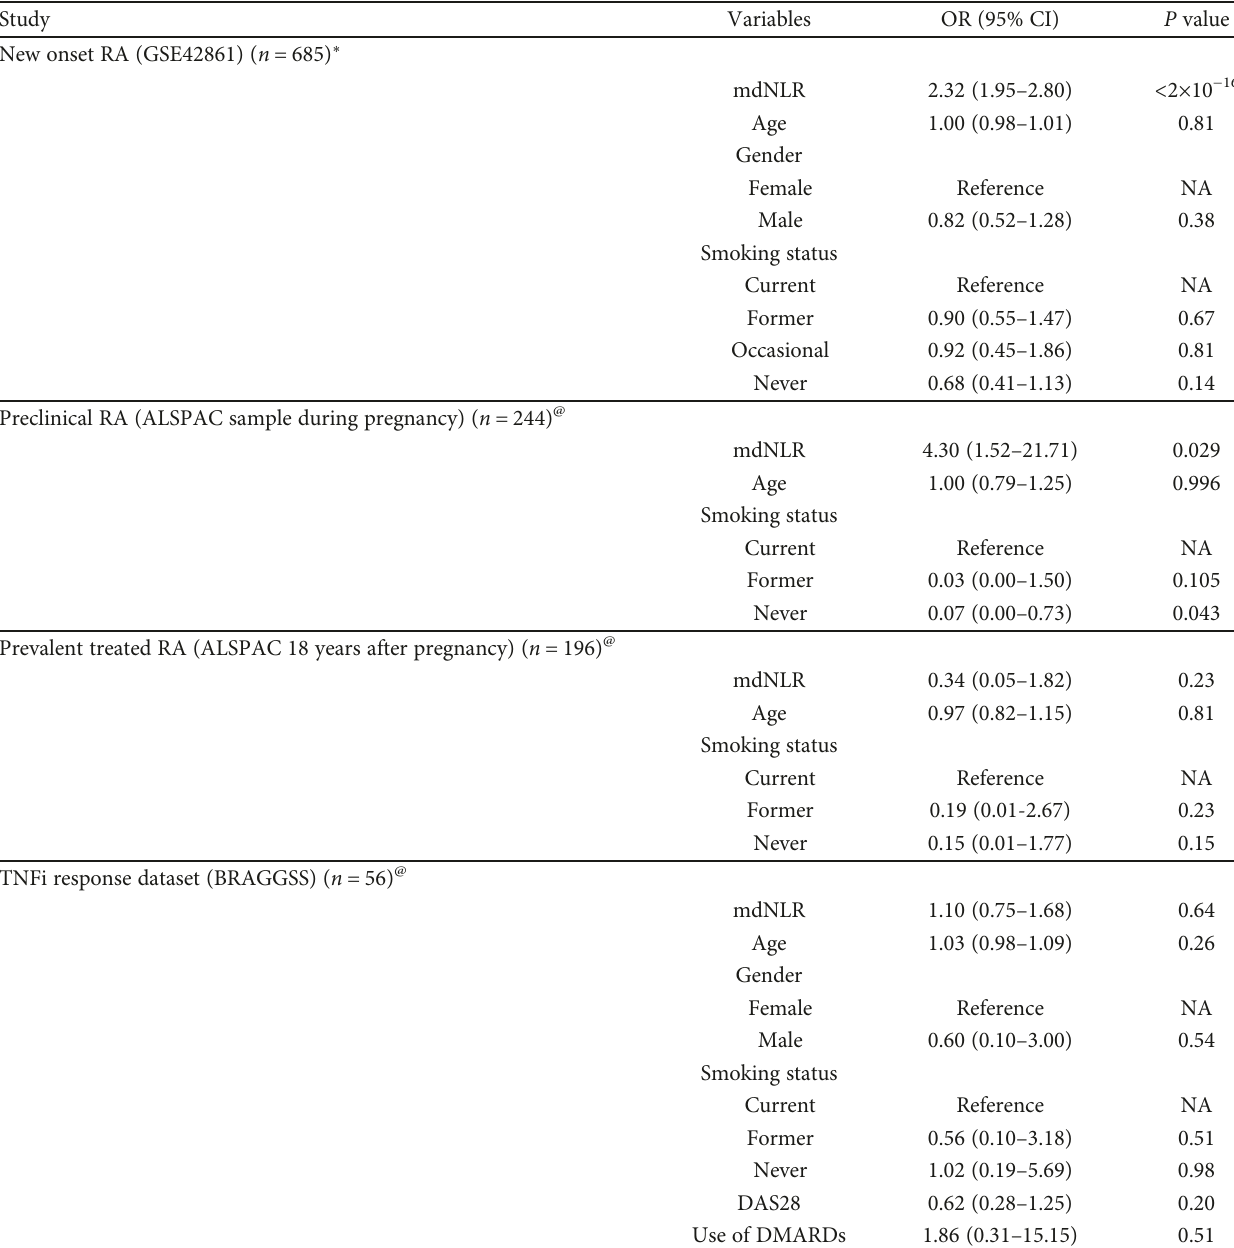
Table 2: Association between mdNLR and rheumatoid arthritis